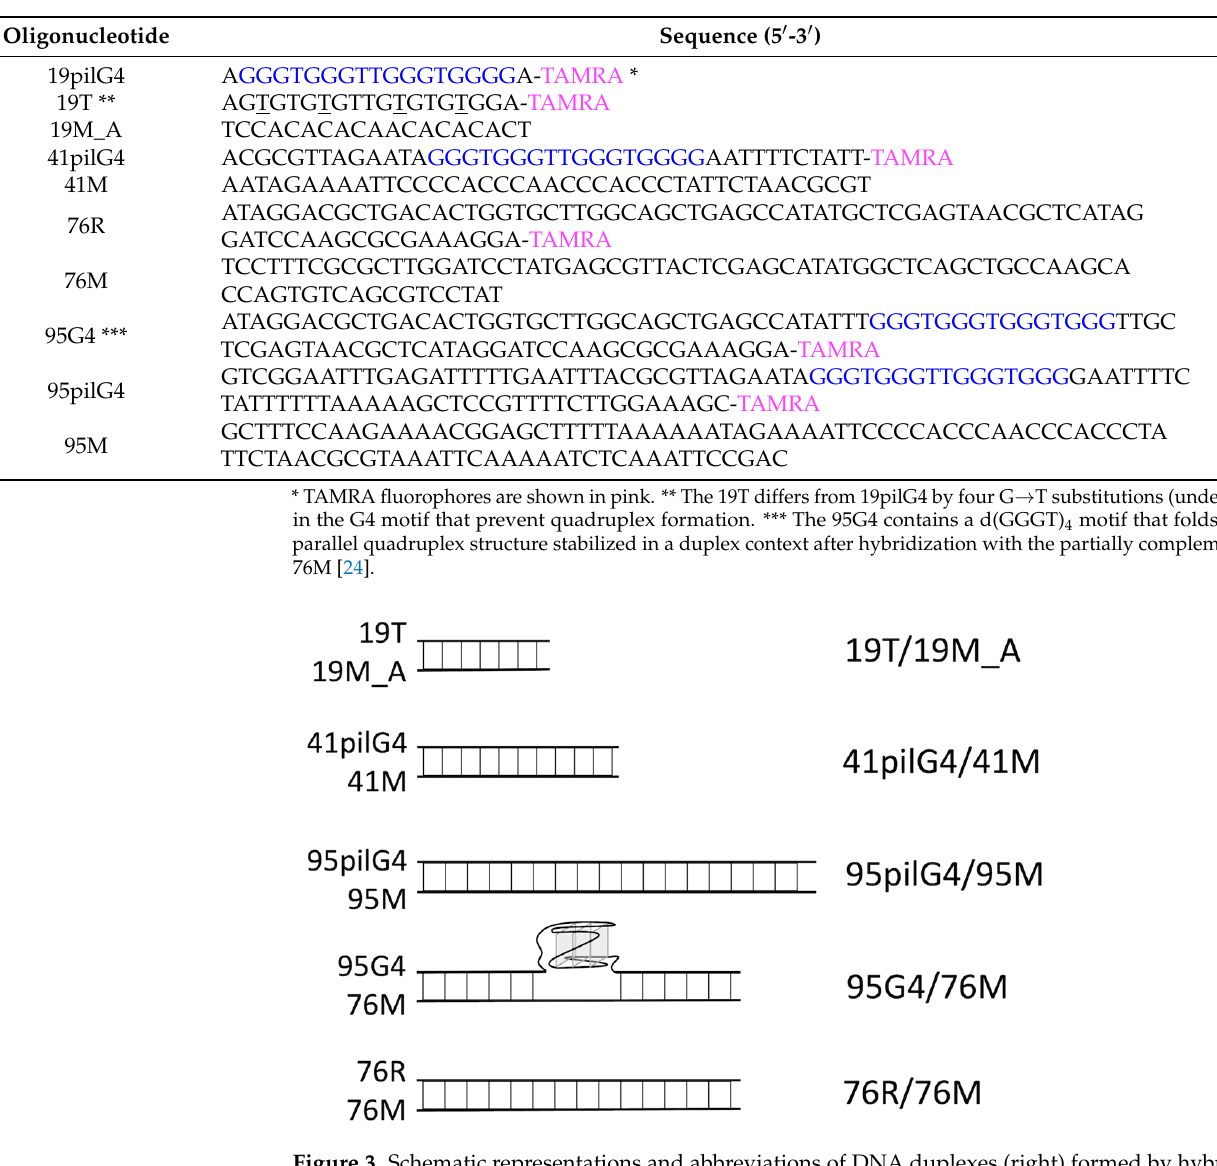
Figure 4. CD spectra of 19pilG4 ( A ), 41pilG4 ( B ), and 95pilG4 ( C ) oligonucleotides recorded at dif- ferent temperatures in 20 mM HEPES bu ff er (pH 7.3) containing 5 mM KCl and 140 mM NaCl (~2 µM oligonucleotide strand concentration). Temperature increased from 30 to 85 °C in 5 °C incre- ments; multicolor lines show the CD spectra at di ff erent temperatures ( Inserts ). CD-monitored melt- ing pro fi les at 265 nm. CD spectra of double-stranded DNA models ( D ) (~2 µM oligonucleotide strand concentration) recorded at 37 °C in 20 mM HEPES bu ff er (pH 8.0) containing 100 mM KCl. It